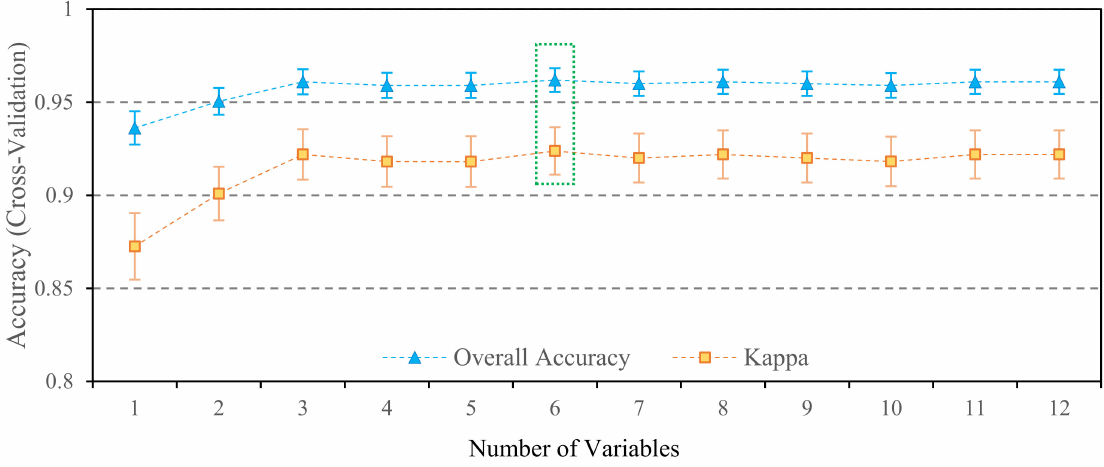
Figure 3. Variability in overall accuracy and Kappa for NDVI time-series analysis (TSA) when using a di ff erent number of NDVI variables. Whiskers indicate the standard deviation of five repeated 10-fold cross-validation. The green box indicates the best accuracy of the model, using the selected optimal feature subset. The best accuracies for NDVI-TSA were produced when six variables were considered. The order of these variables is NDVI_Nov, NDVI_Dec, NDVI_May, NDVI_Jun, NDVI_Apr, and